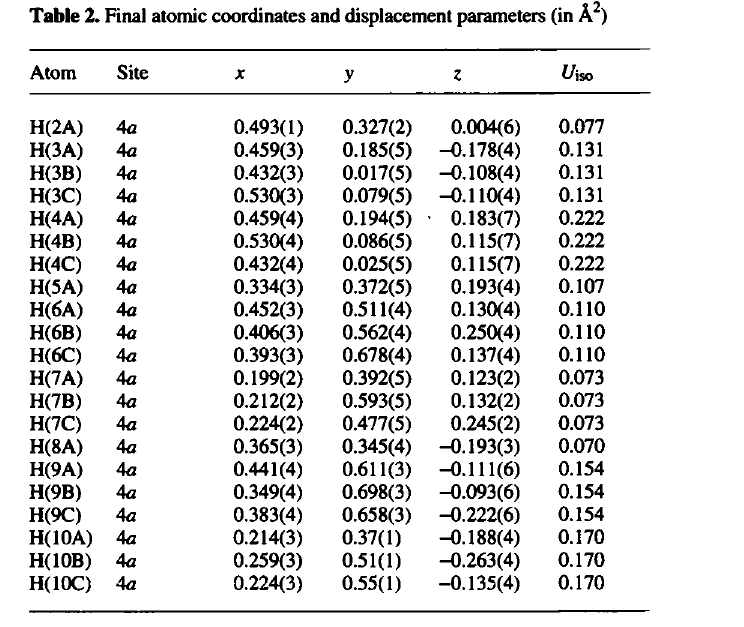
Table 2. Final atomic coordinates and displacement parameters (in